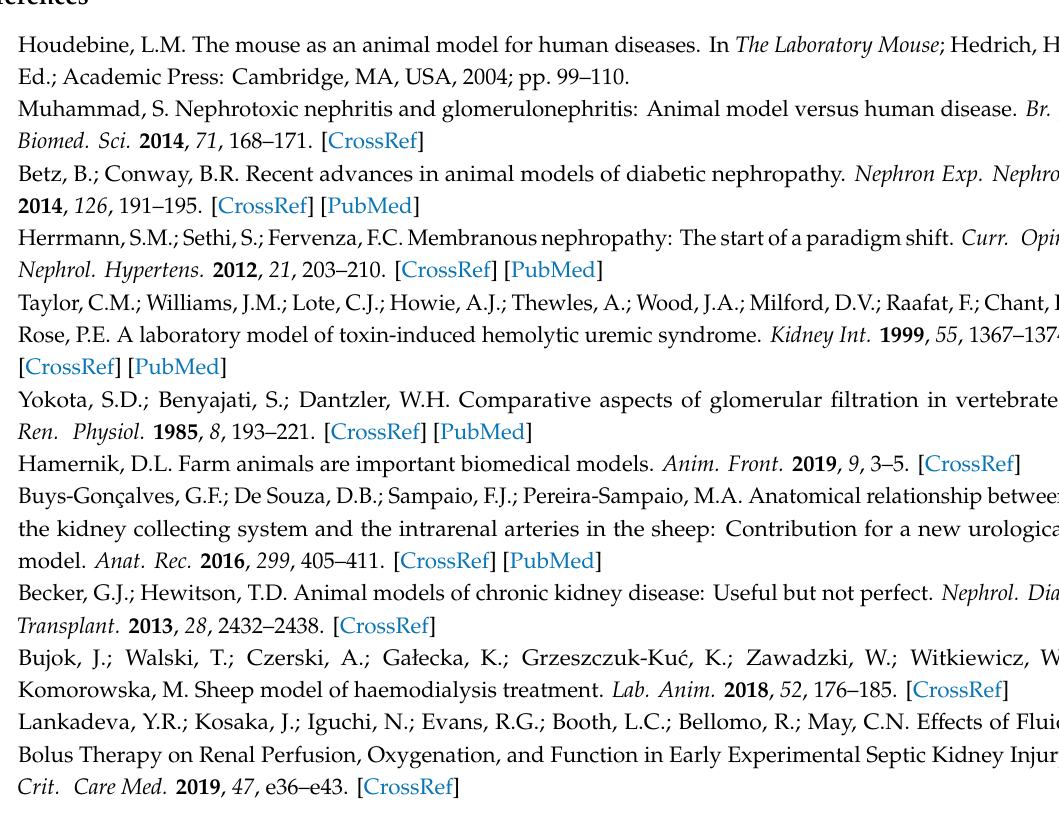
Table S1: Iohexol plasma clearance in swine. Two compartment model CL2 is the reference method. CL1: one compartment model; CL1f: one compartment model corrected with a formula; SM: simplified two-compartment using 7 points. (MAPE = mean absolute percentage error, Figure S1: Bland–Altman plots of the di ff erence between the glomerular filtration rate (GFR) values measured by the reference method (two-compartment clearance: CL2) and ( A ) the one compartment method adjusted by a formula CL1f and ( B ) the simplified method (SM) versus the di ff erences of the means of both. The straight and dashed lines indicate mean di ff erence and 95% limits of agreement, respectively, Table S2: Agreement between the two-compartment reference method (CL2) with the one-compartment model adjusted by an equation (CL1f) and the two-compartment simplified method (SM) in a group of 16 pigs. TDI: total deviation index, TDI (total deviation index); CCC (concordance correlation coe ffi cient); CP (coverage probability); LA (limits of agreement, mL /